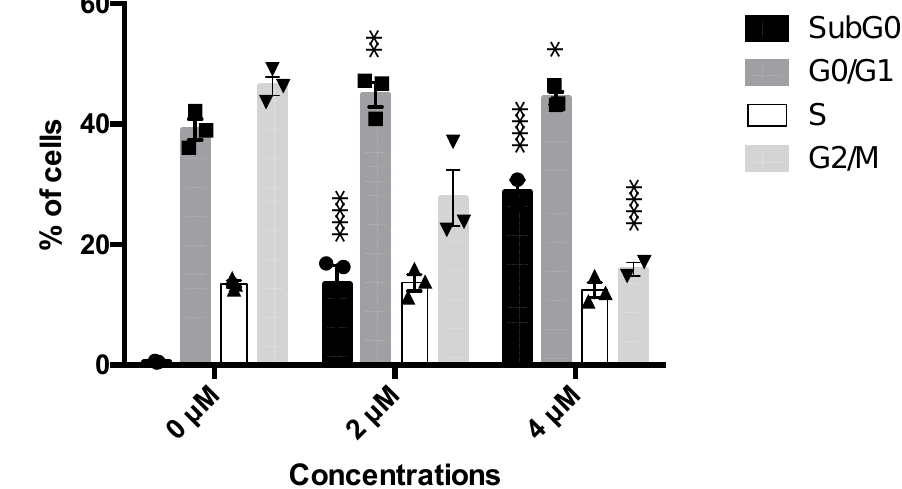
Figure 1. Histograms of cell-cycle distribution after Jurkat treatment with compound 5b for 24 h. * p < 0.05; ** p < 0.01; **** p < 0.0001 versus untreated cells. Results are expressed as mean ± SEM